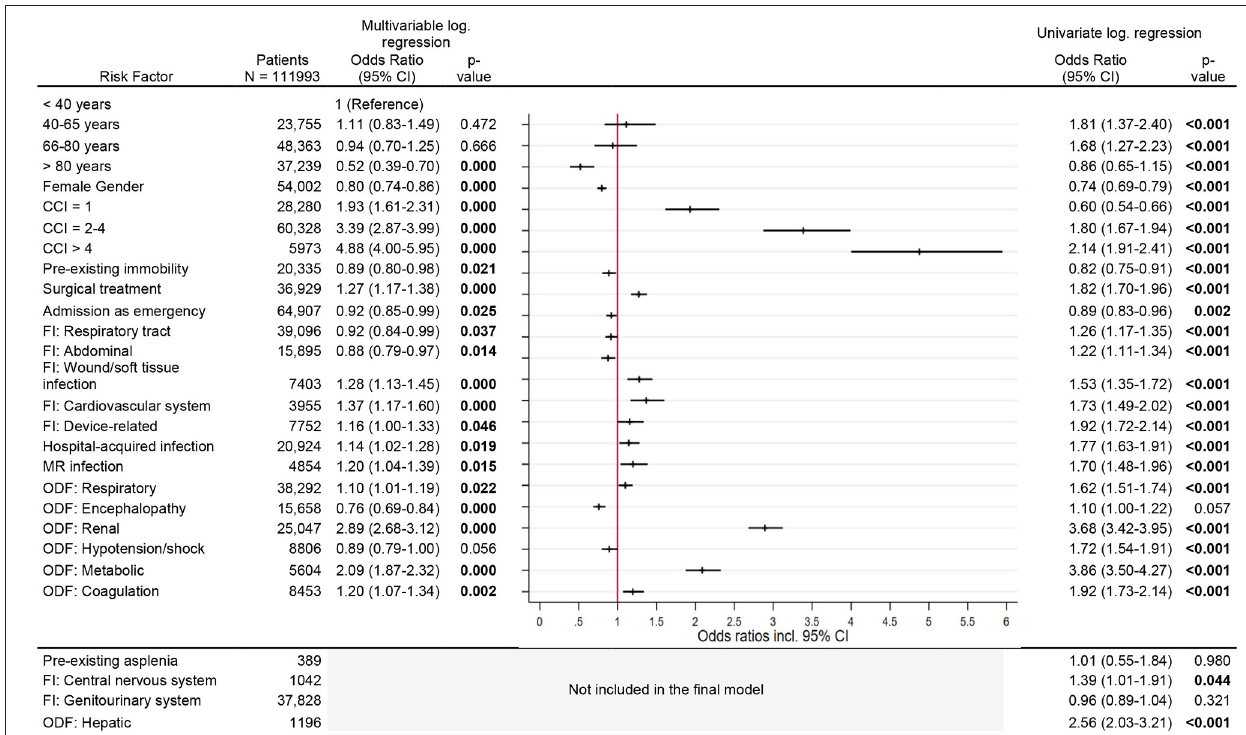
FIGURE 3 | Risk factors for new diaysis dependency. Legend: CCI, Charlson Comorbidity Index; FI, Focus of infection; MR, Multi-resistant; ODF, Organ